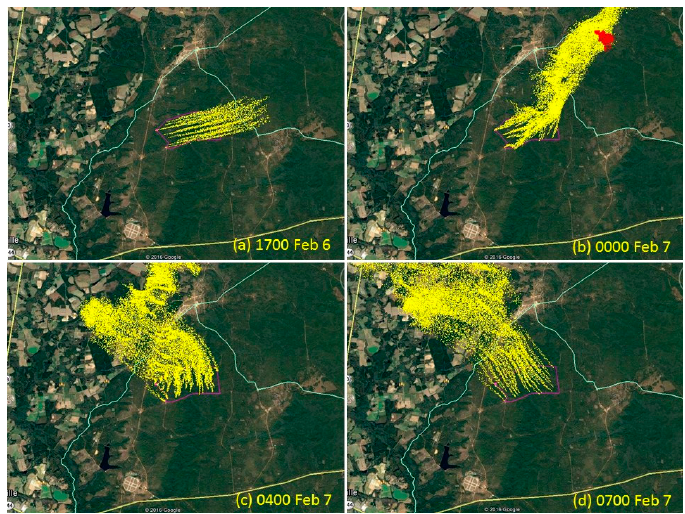
Figure 9. PB-P simulation of smoke during night of 6 February 2011 at four times ( a – d ). Yellow indicates smoke particles. Red indicates formation of fog. The pink area is the hypothetical burn site of Block 3.